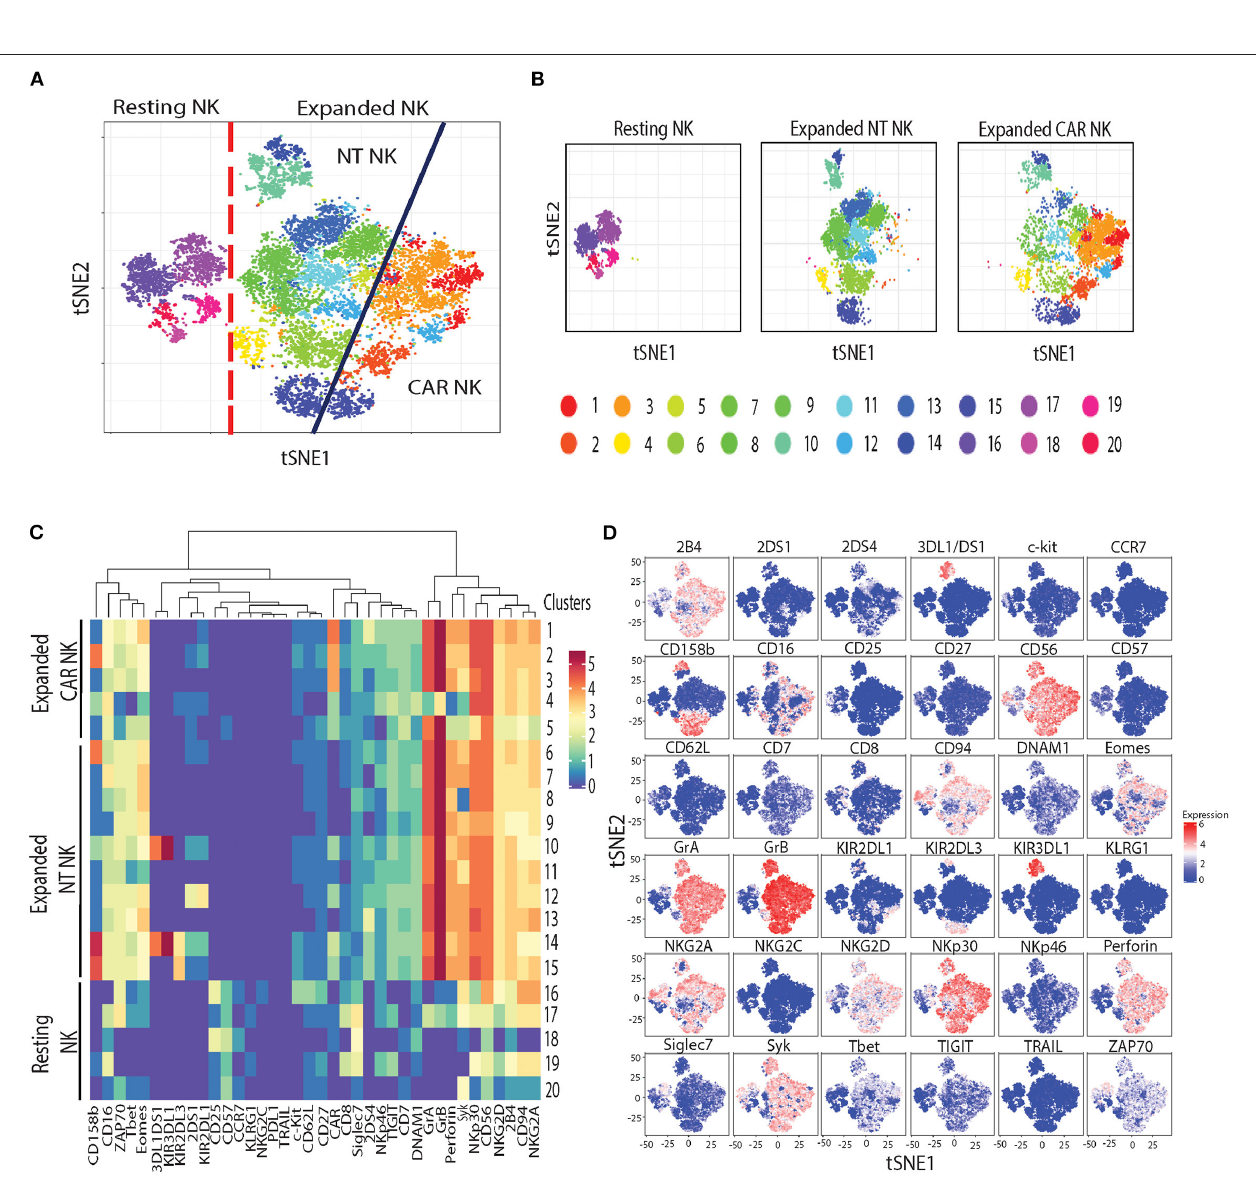
FIGURE 5 | Phenotypic characterization of resting vs. uAPC-expanded NK cells. (A) The t-SNE map generated from FlowSOM analysis showing the 20 clusters of resting NK cells (freshly isolated at day 0) and uAPC-expanded NK cells (NT and iC9/CAR.19/IL-15 NK cells) for 14 days. (B) Individual t-SNE maps showing clusters corresponding to resting NK cells (left panel) or expanded NT NK cells (center panel) vs. expanded iC9/CAR19/IL-15 (CAR) NK cells (right panel) for 14 days with uAPC. (C) Comparative heatmap of mass cytometry data showing the expression of NK cell surface markers, cytotoxicity markers and transcription factors in resting NK cells and uAPC-expanded NK cells [NT and iC9/CAR19/IL-15 (CAR)]. Each column reflects the expression of a certain NK cell marker for each annotation and each row represents a separate cluster identified by FlowSOM analysis. Color scale shows the expression of each marker, with red representing higher expression and purple lower expression. (D) Individual t-SNE maps showing the expression of NK cell markers for resting NK cells vs. uAPC- expanded NK cells (NT and iC9/CAR19/IL-15 NK cells). Color scale indicates the signal intensity, ranging from low (blue) to high (red) after arcsine transformation.